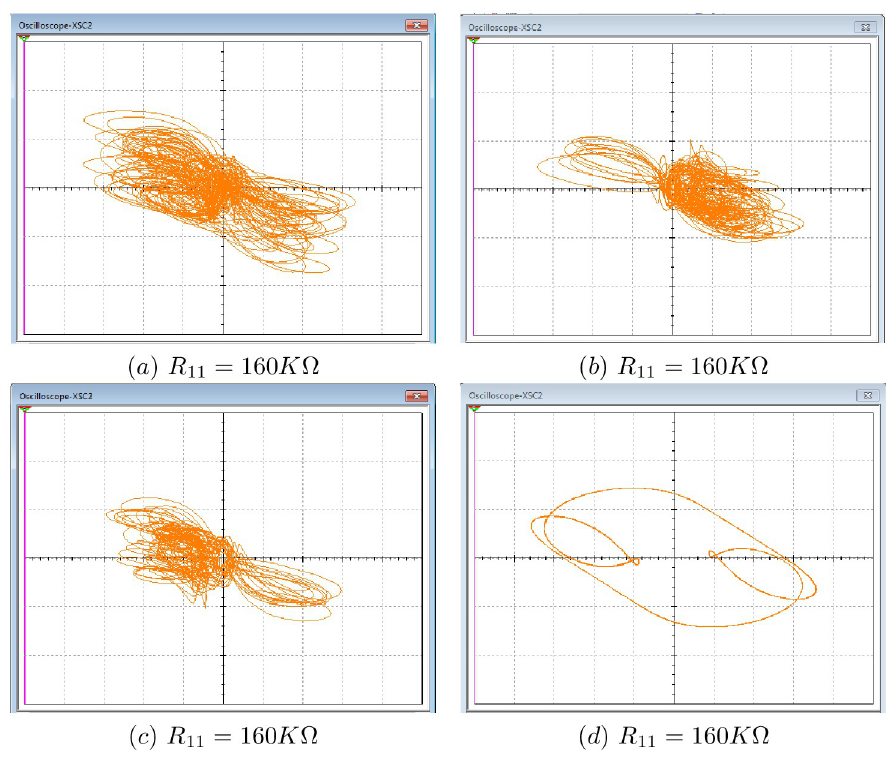
Fig 23. Experimental phase portraits of four coexisting attractors: (a), (b) and (c) three chaotic attractors with initial points (0,0,0,0,0,0,0,0,0,0.5), (0,0,0,0,0,0,0,0,0, ± 1); (d) periodic attractor with initial point